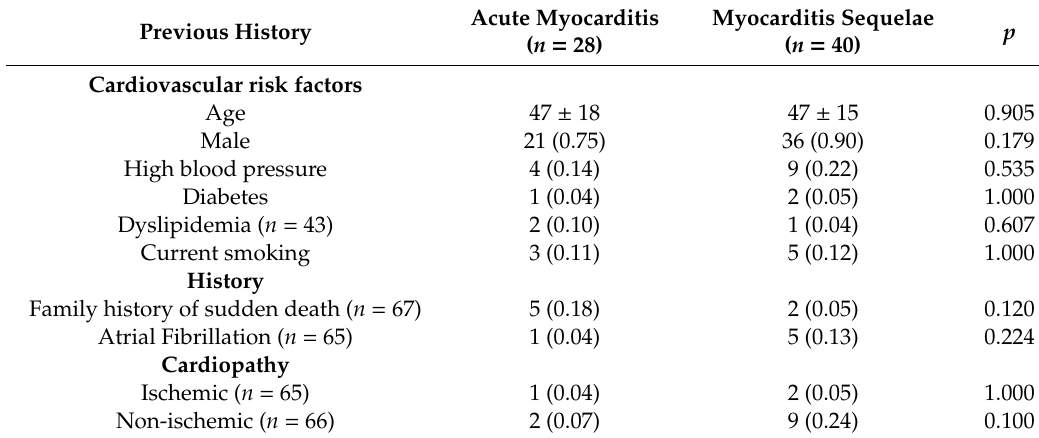
Table 1. Baseline